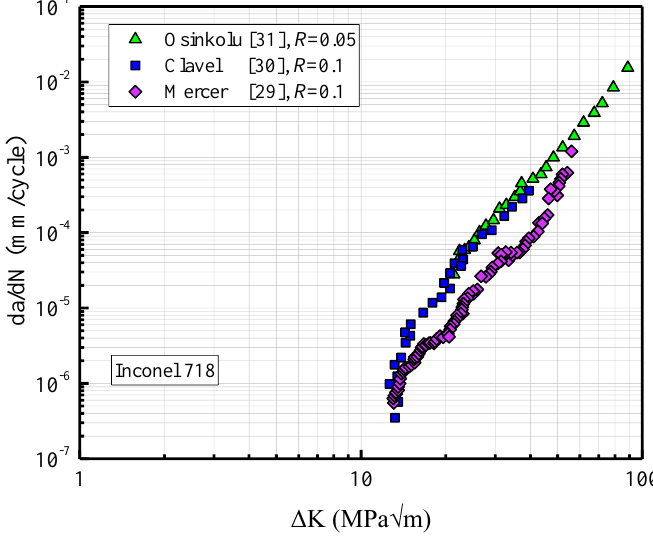
Figure 12. Fatigue crack growth rate at a stress ratio of 0.1 for Inconel 718.